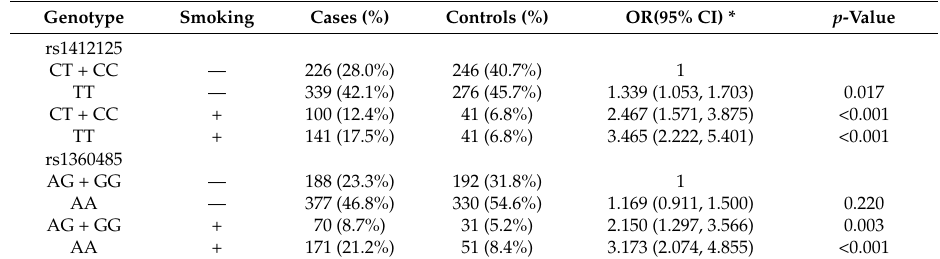
Table 5. Crossover analysis of interaction between SNPs and tobacco exposure in northeast Chinese